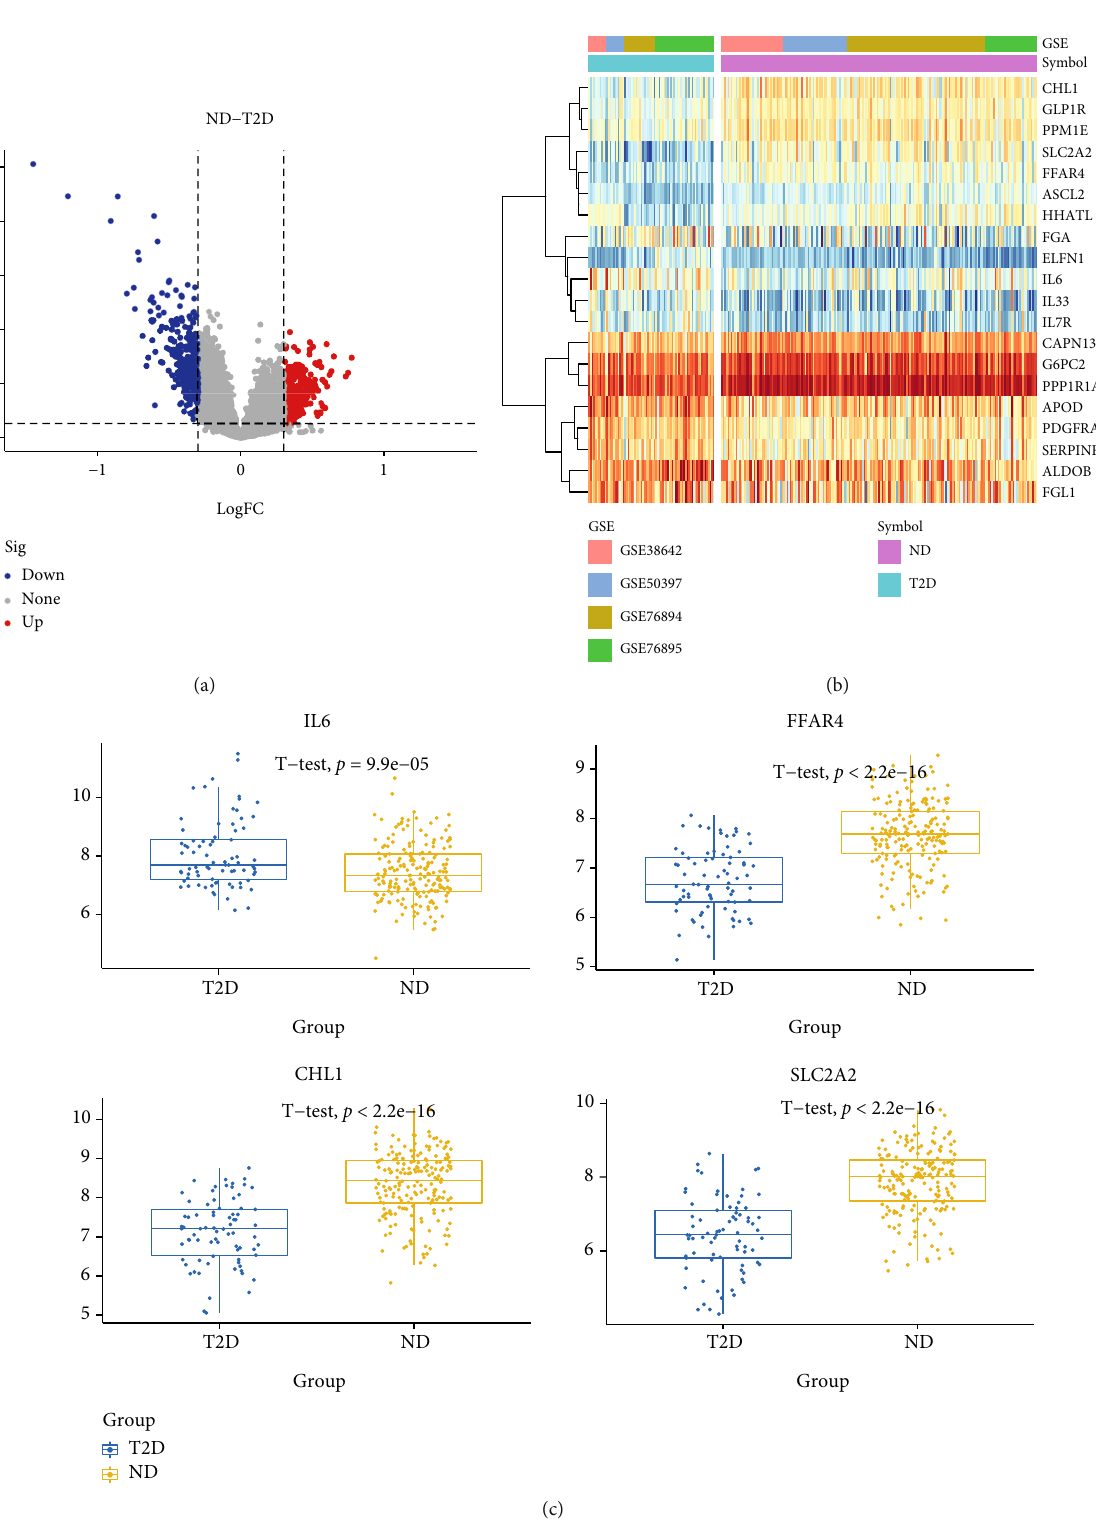
Figure 2: Volcano plots, heatmaps, and gene expression pro fi les of DEGs in ND-T2D. (a) Number and distribution of up and downregulated genes. (b) Heatmap for DEGs generated by comparison in ND and T2D. Row is the gene, and column name is the samples, which is not shown in plot. DEGs were determined by Wilcoxon rank sum test with q < 0 : 05 and log 2FC > 0 : 3 as the signi fi cance threshold. (c) Expression levels of some DEGs in ND and